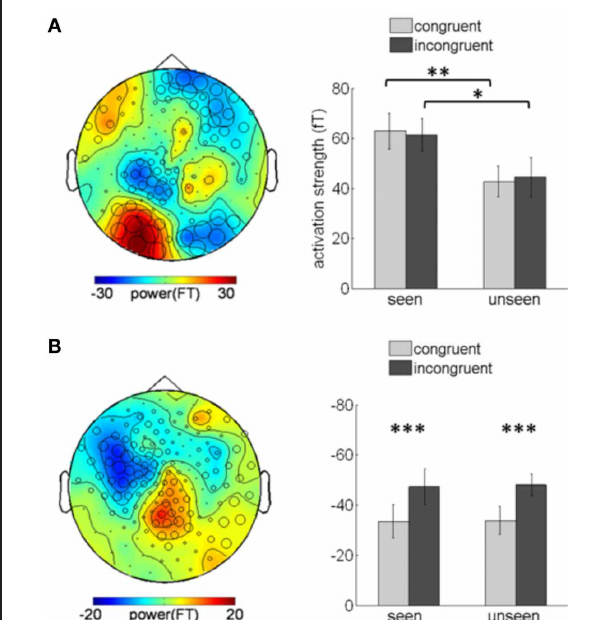
FIGURE 3 | Awareness and color-congruency related clusters. (A) Awareness-related effects. Left, topographic map of the difference between seen and unseen gratings, averaged over the 130–350 ms time window. Sensors recruited in the significant awareness-related cluster are indicated by an open circle whose diameter is proportional to the time during which the sensor is involved in the cluster. The maximal difference is observed over occipital sensors. Right, bar graph of activation strength in the awareness-related cluster, plotted separately in the four conditions of interest. A significant awareness effect is observed both in congruent (paired t -test, ∗∗ p < 0 . 01) and incongruent ( ∗ p < 0 . 02) trials. (B) Congruency-related effect. Left, topographic map of the difference between congruent and incongruent trials, averaged over the 130–350ms time-window and distribution of the sensors involved in the congruency-related cluster. The maximal difference is located over left parietal and central sensors. Right, bar graph of the cluster activation strength, plotted separately in the four experimental conditions. A significant difference between congruent and incongruent trials can be observed no matter whether the subject reported seeing the grating or not (paired t -tests, congruent vs. incongruent, ∗∗∗ p < 0 . 001). Error bars indicate standard error of the